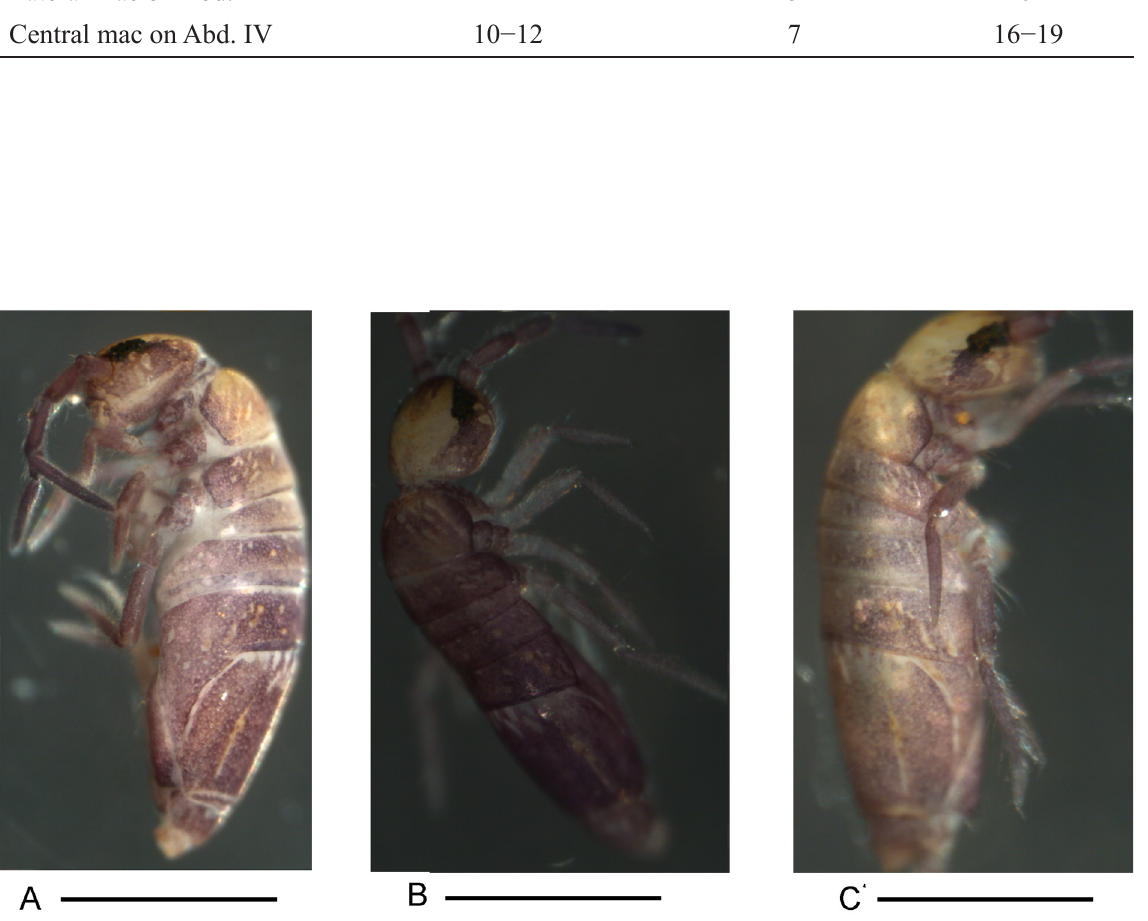
Fig. 8. Willowsia tanae sp. nov. A − C . Habitus. Scale bars: 500 μm.